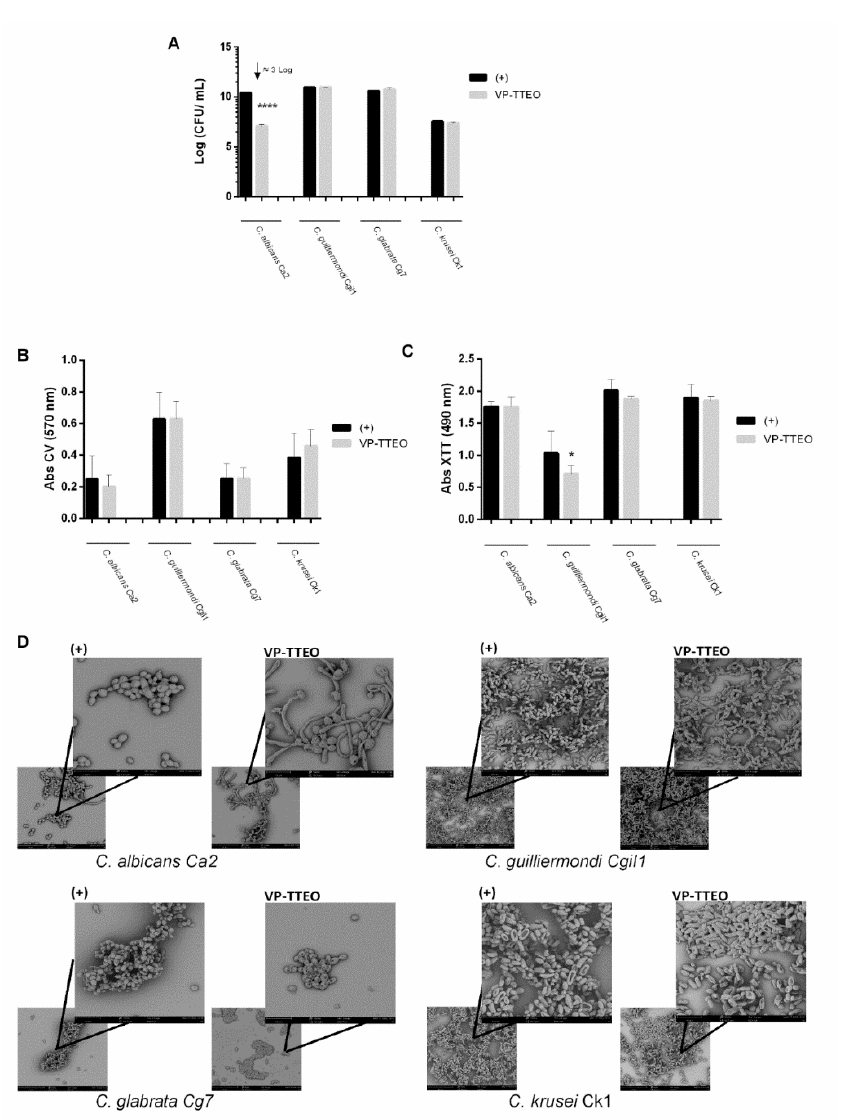
Figure 3. Effect of the vapor phase of tea tree essential oil (VP-TTEO) on pre-formed biofilms of antifungal-resistant Candida isolates. Biofilms of C. albicans Ca2, C. guilliermondii Cgi1, C. glabrata Cg7, and C. krusei Ck1 were developed in the absence (control) and presence of the VP-EOs: ( A ) Number of cultivable cells (Log CFU/mL). ( B ) Absorbance values of crystal violet solutions (Abs CV) and ( C ) absorbance values of XTT solutions (Abs XTT). * indicates statistical reduction of biofilms cell cultivability in comparison with the respective control (* p < 0.1, **** p < 0.0001). ( D ) Scanning electron microscope (SEM) images. The bar represents 30 µm (lower magnification image) or 10 µm (higher magnification image).